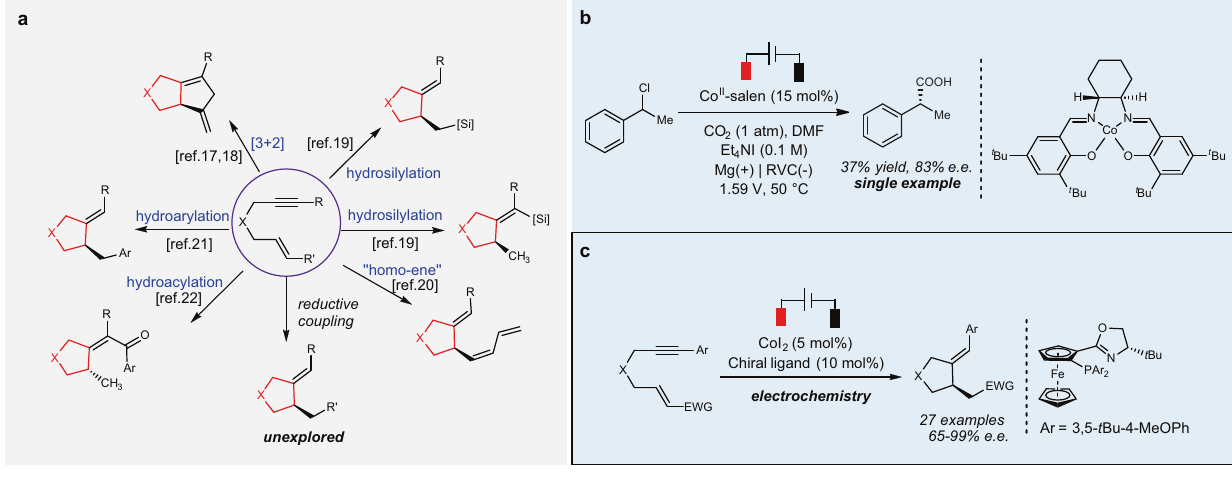
Fig. 1 | Background and project synopsis. a Asymmetric synthetic approaches involving 1,6-enynes by cobalt. b Precedent enantioselective carboxylation